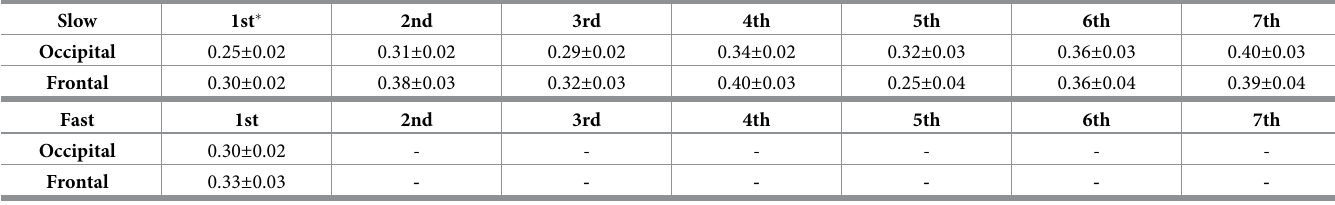
Table 1. Timing (sec.) of peak theta activity amplitude to memory item presentation. Slow 1st � 2nd 3rd Occipital 0.25 ± 0.02 Frontal Fast 1st Occipital 0.30 ± 0.02 - Frontal 0.33 ± 0.03 (Mean ± SE, n = 29 � significant difference between occipital and frontal: p <